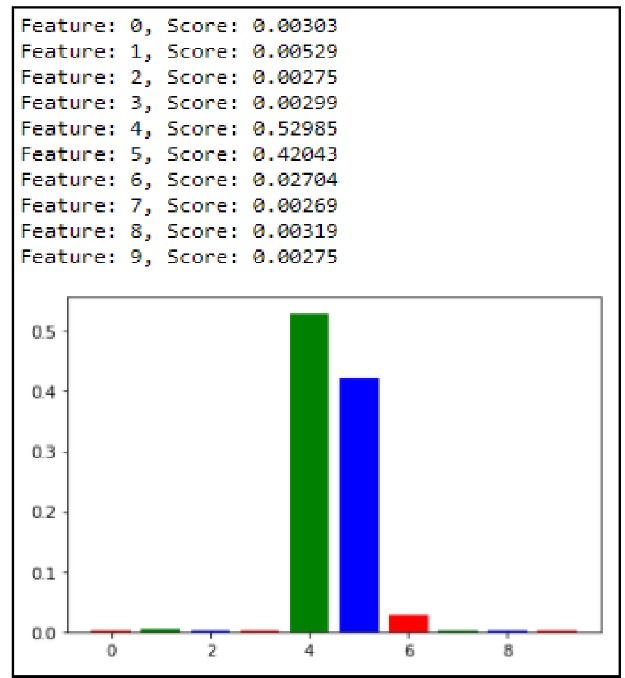
Figure 14. Feature importance graph for random.